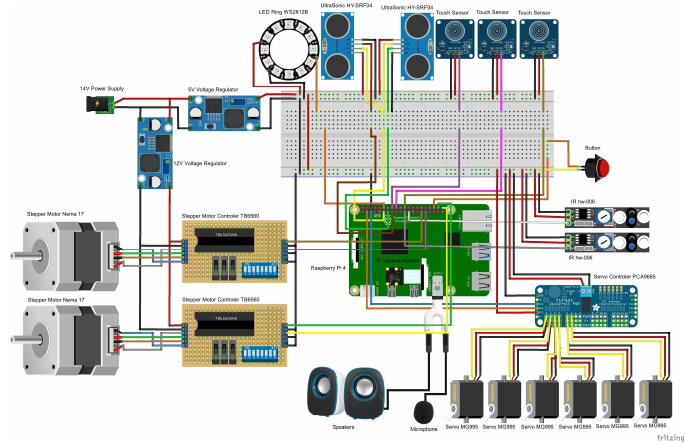
Figure 2. Diagram of the